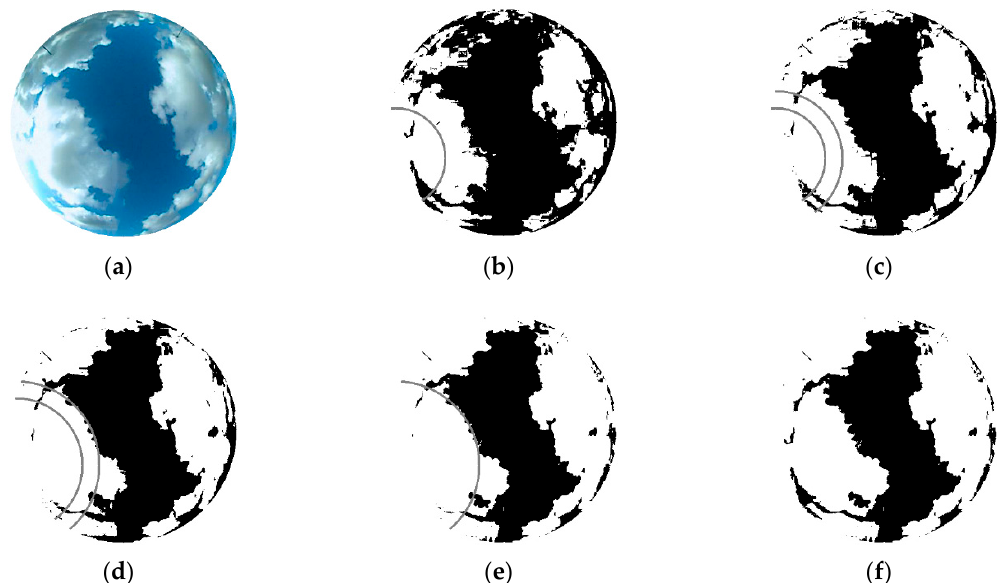
Figure 7. ARGD processing: ( a ) Original image; ( b ) ARGD binary image with k = 1.3; ( c ) ARGD binary image with k = 1.4; ( d ) ARGD binary image with k = 1.5; ( e ) ARGD binary image with k = 1.7; ( f ) ARGD binary image.